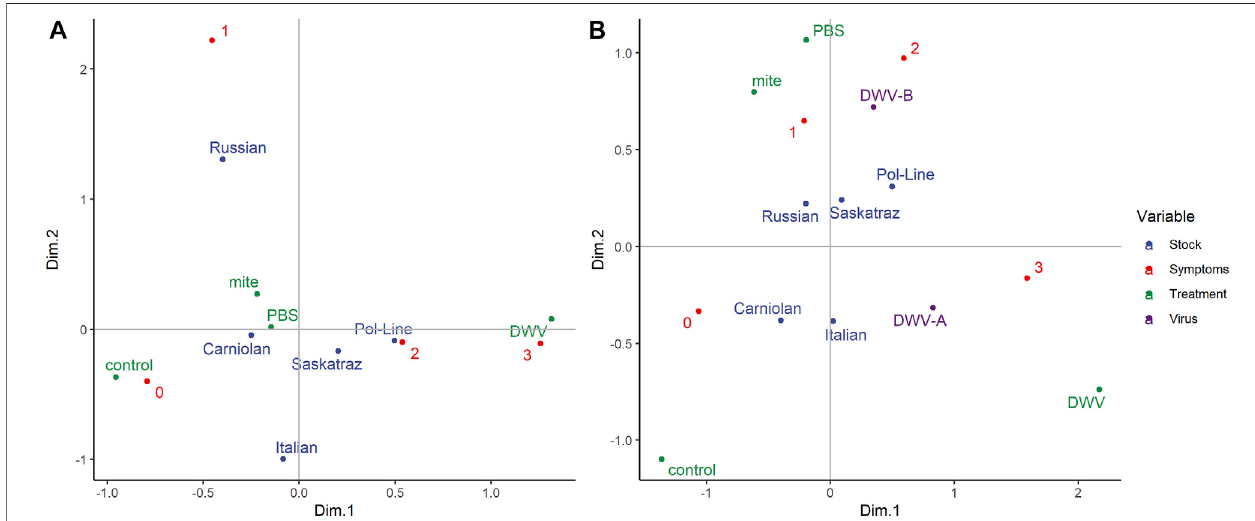
FIGURE8 | Multivariate visualization ofbee stock, treatments, and symptom severity. (A) Multiple correspondence analysisto evaluate theinteractionsamong the following categorical variables: bee stocks, treatments, and DWV symptom severity (scale 0 – 3, 0 represents no symptoms, and 3 represents debilitating morphological symptomsbasedon SupplementaryFigureS1 ). (B) Factoranalysisofmixeddatatoevaluatetheinteractionsamong fi vebeestocks,fourtreatmentgroups,andDWV symptom severity with the addition of log-transformed levels (virus) of both DWV variants (A and B). Both fi gures represent the correlations between variables, where variables with similar pro fi les group together. Sample sizes were based on bees with DWV quanti fi cation from head tissues (N = 180